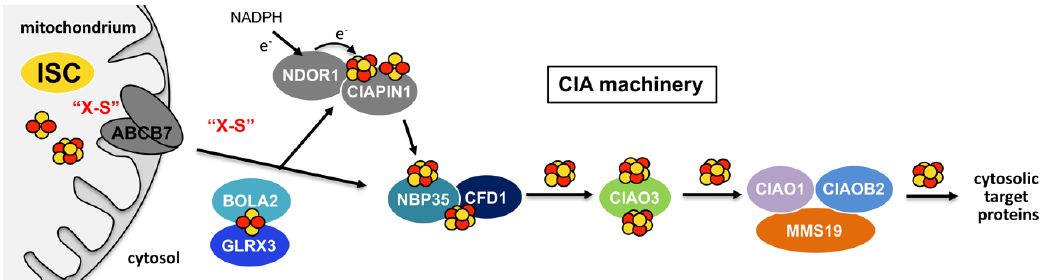
Figure 9. Model of the cytosolic Fe-S cluster assembly (CIA) in humans. Assembly of cytosolic Fe-S clusters starts in mitochondria with components of the early ISC machinery synthesizing a sulfur-containing precursor (X-S) that is subsequently exported to the cytosol by the ABC transporter ABCB7. The CIA machinery involves [4Fe-4S] cluster assembly by the CFD1-NBP35 complex serving as a cluster scaffold. This reaction requires electron input from the flavin-oxidoreductase NDOR1 and the Fe-S protein CIAPIN1. The complex of GLRX3-BOLA2 facilitates [2Fe-2S] cluster insertion into CIAPIN1. In the next step, the CFD1-NBP35-bound [4Fe-4S] cluster is released and transferred to the majority of target Fe-S apoproteins with the help of CIAO3. Fe-S cluster targeting to individual